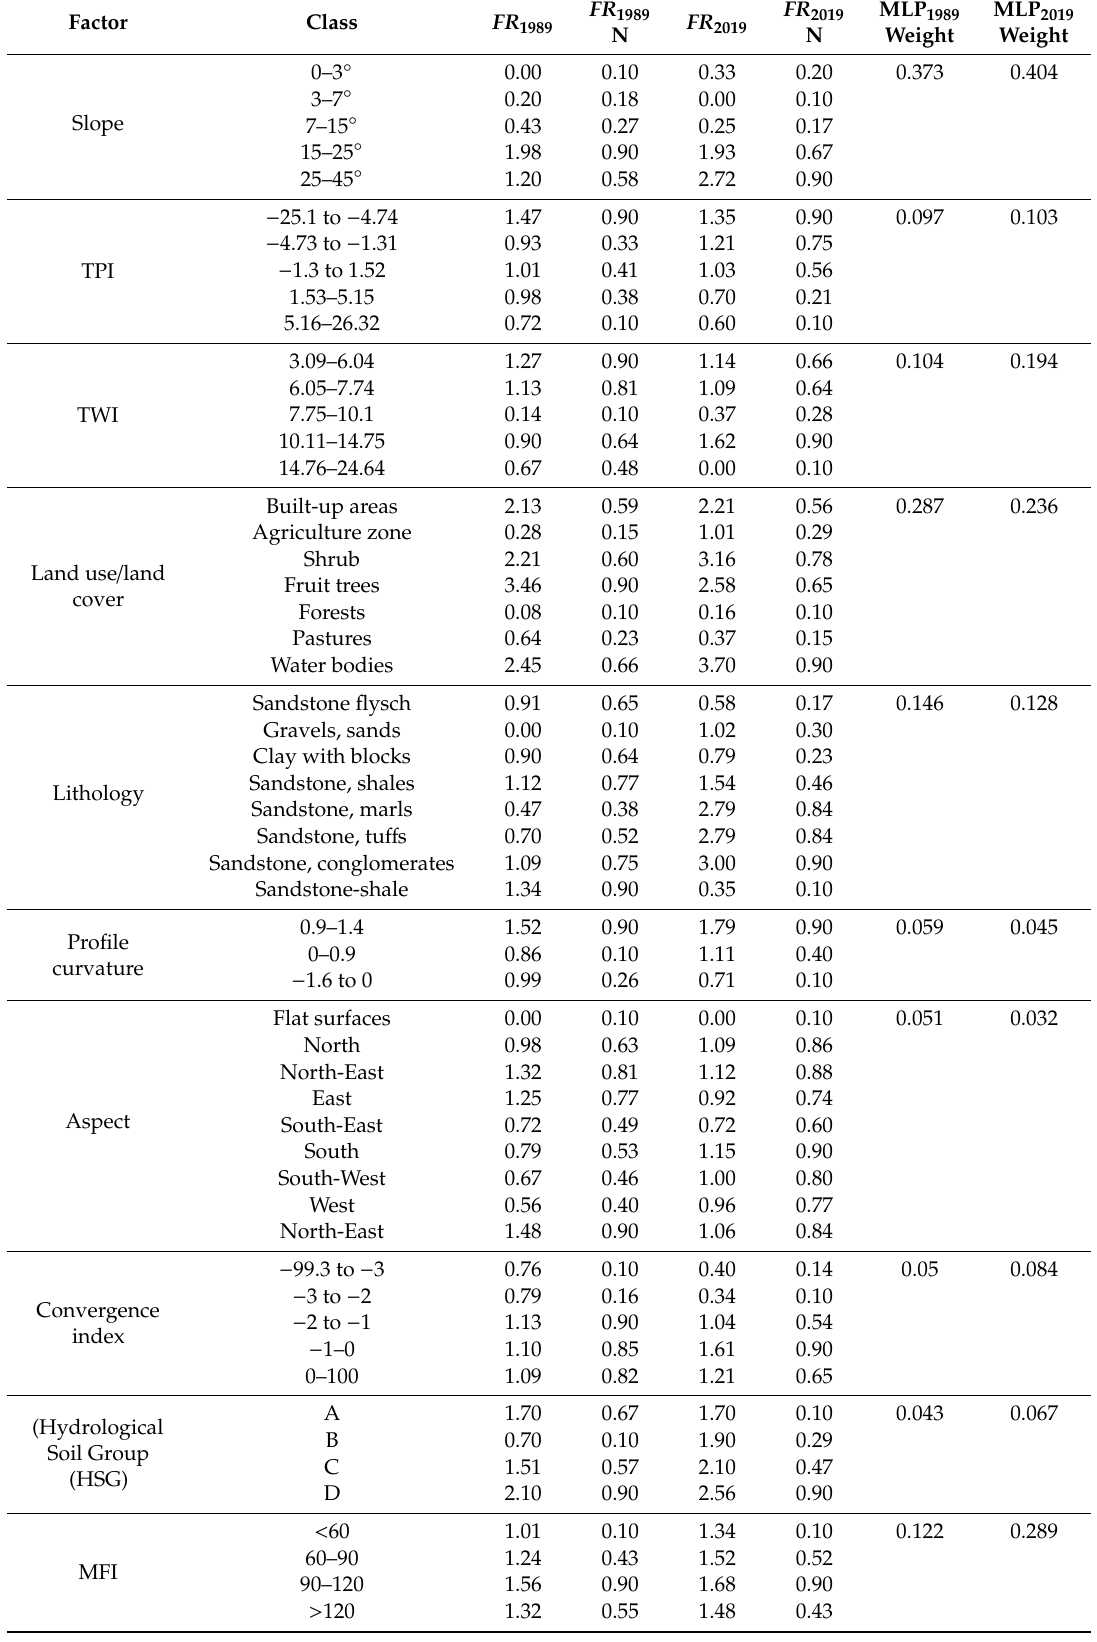
Table 4. Frequency ratio and multilayer perceptron